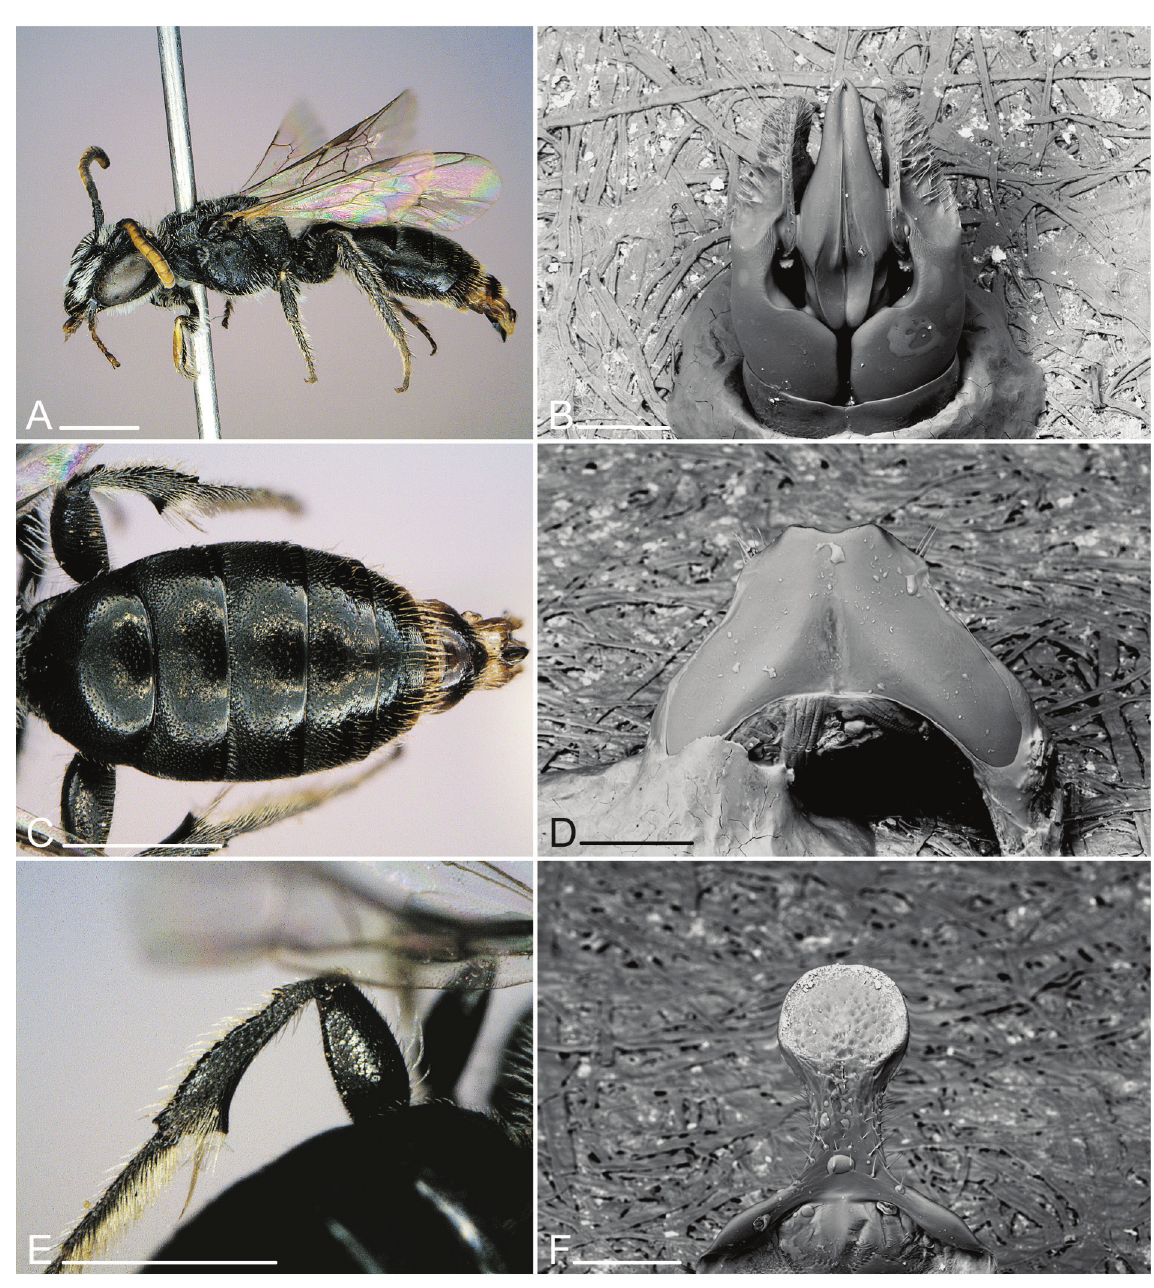
Fig. 22. Scrapter papkuilsi sp. nov., ♂. A . Lateral view. B . Genitalia (dorsal view, SEM). C . Metasoma (dorsal view). D . S7 (dorsal view, SEM). E . Hind tibia. F . S8, apical end (SEM). Scale bars: photos: 1 mm, SEM: 0.1